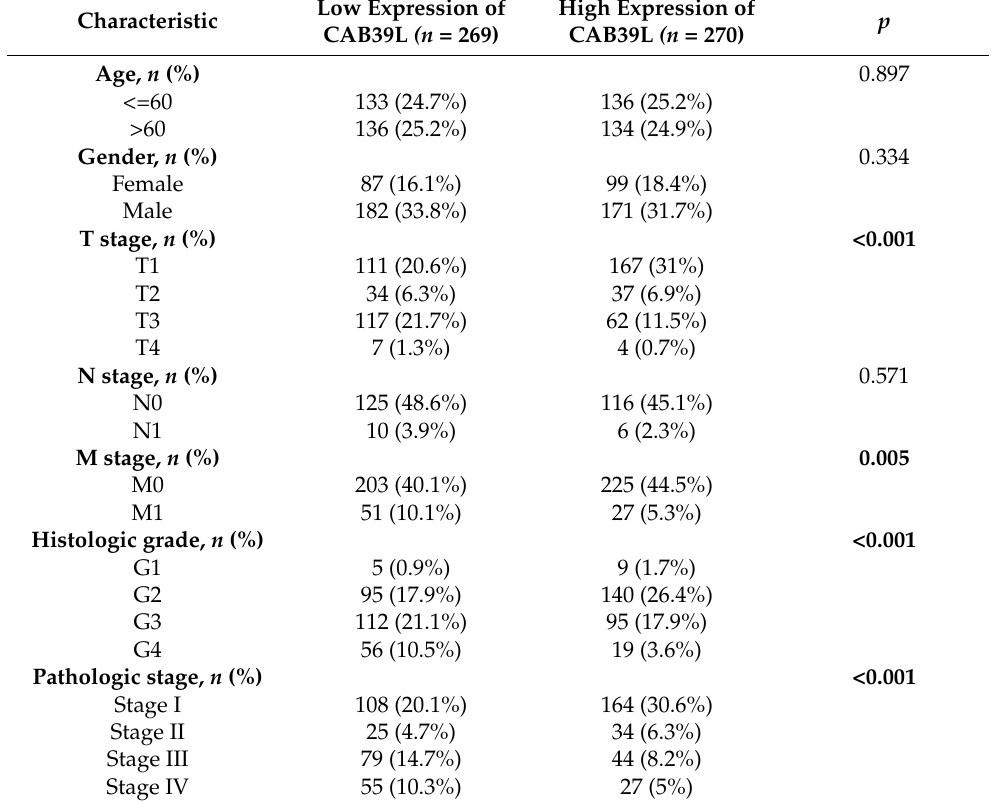
Table 1. Association of CAB39L mRNA expression with clinical characteristics in KIRC